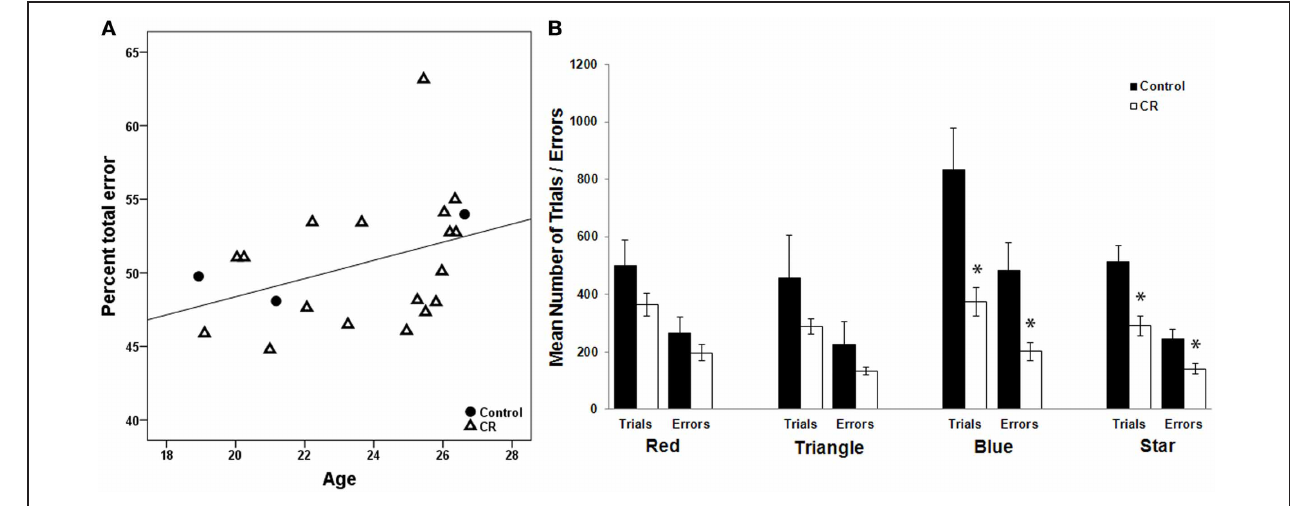
FIGURE 1 | (A) There is a significant positive relationship between age and percentage of total errors to total trials on the WSCT across 4 control and calorie restricted (CR) animals (Spearman’s coefficient = 0.498,